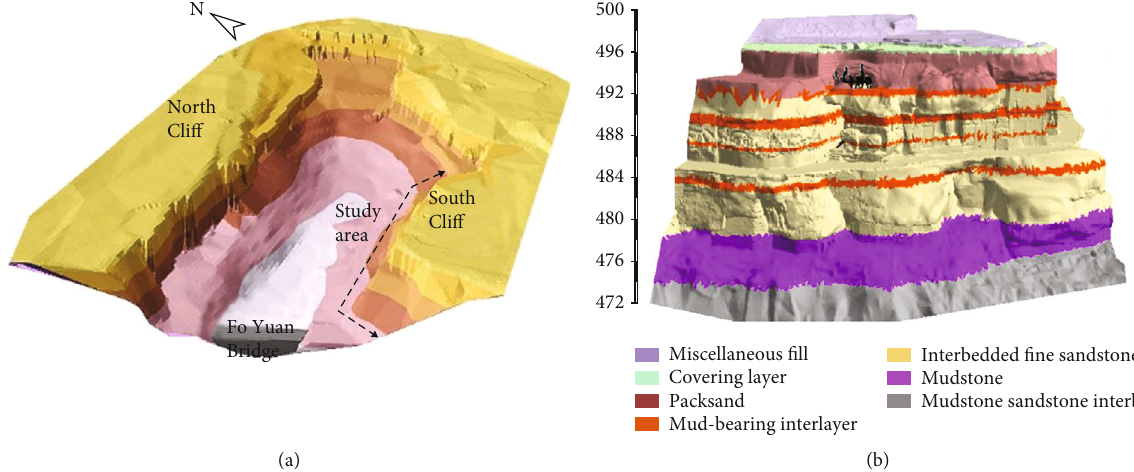
Figure 1: Topography and stratigraphic lithology of the gully in Big Buddha Bay: (a) three-dimensional topographic map of the Big Buddha Bay gully and (b) lithology section of the South Cli ff of Big Buddha